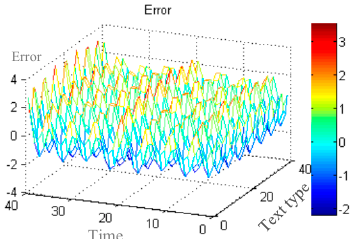
Figure 10. Error secondary optimization.